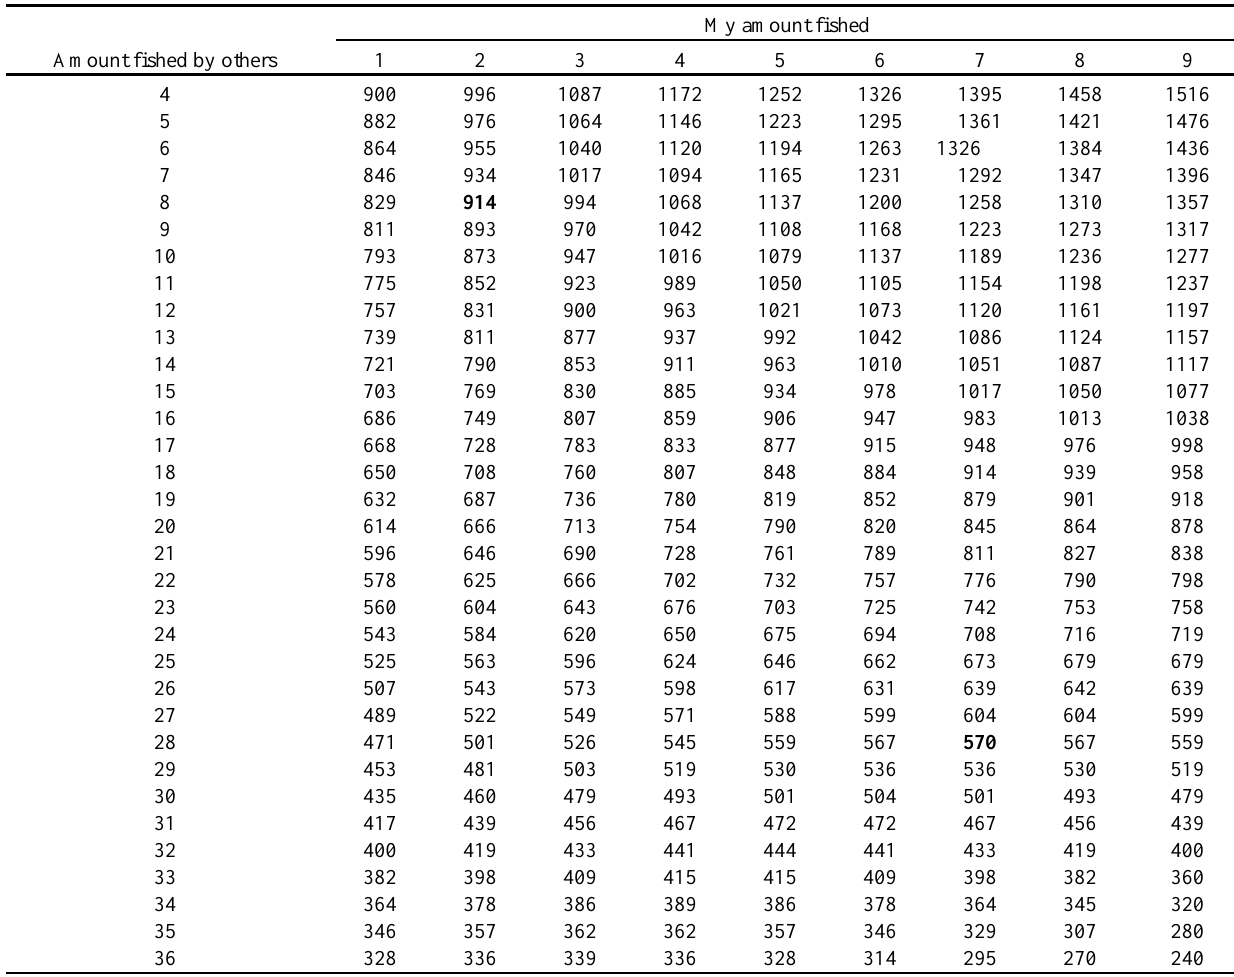
Table 2 . Earnings table